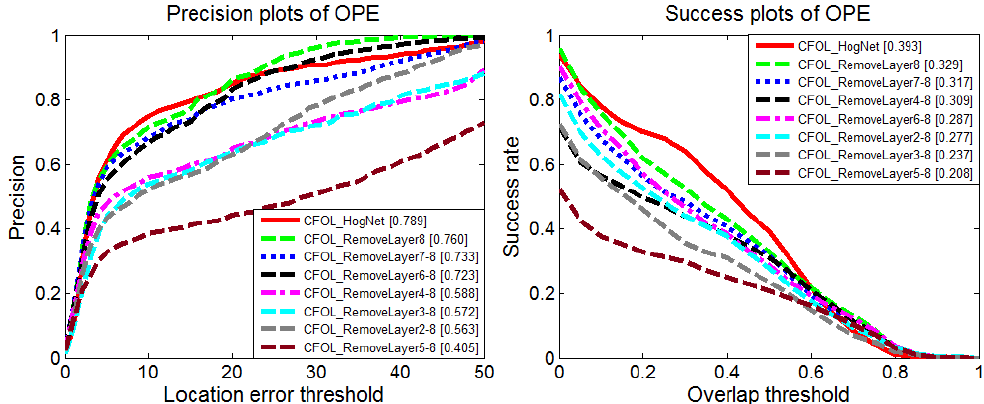
Figure 11. Performance comparison with different network